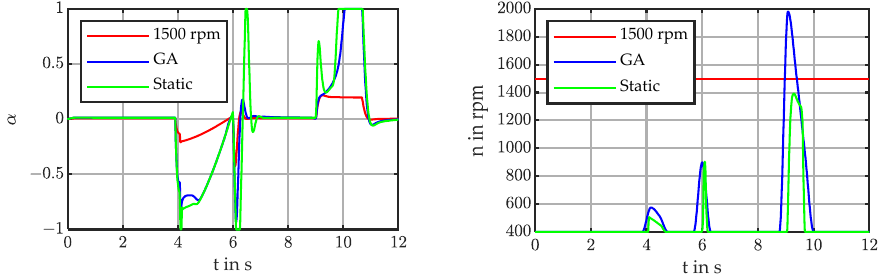
Figure 6. Left: motor speed trajectories generated by the optimization algorithms; right: resulting Figure 5. Schematic representation of the implementation of the drive unit with two control varia- swash plate angles during the sequence. bles and offline optimization for the control variable distribution.